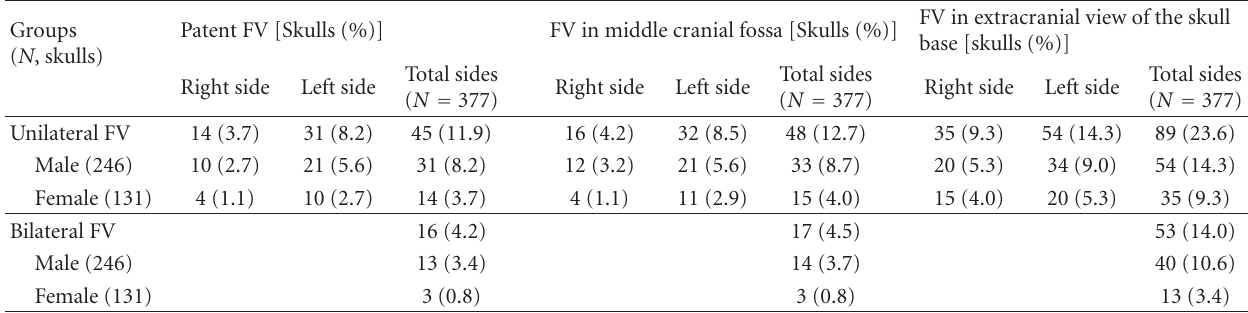
FV in extracranial view of the skull base [skulls (%)]